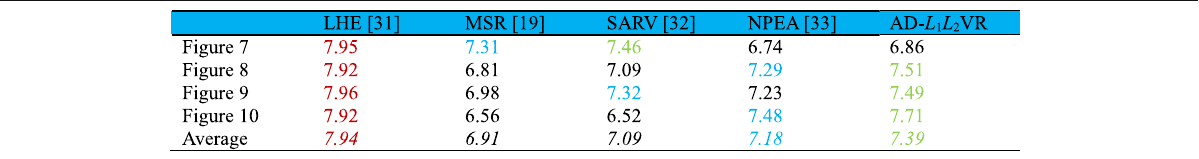
italics values are the average values that can evluate the performance of different methods more accurately. red color data represents the highest value, green color data represents the second highest, and blue color data represents the third highest